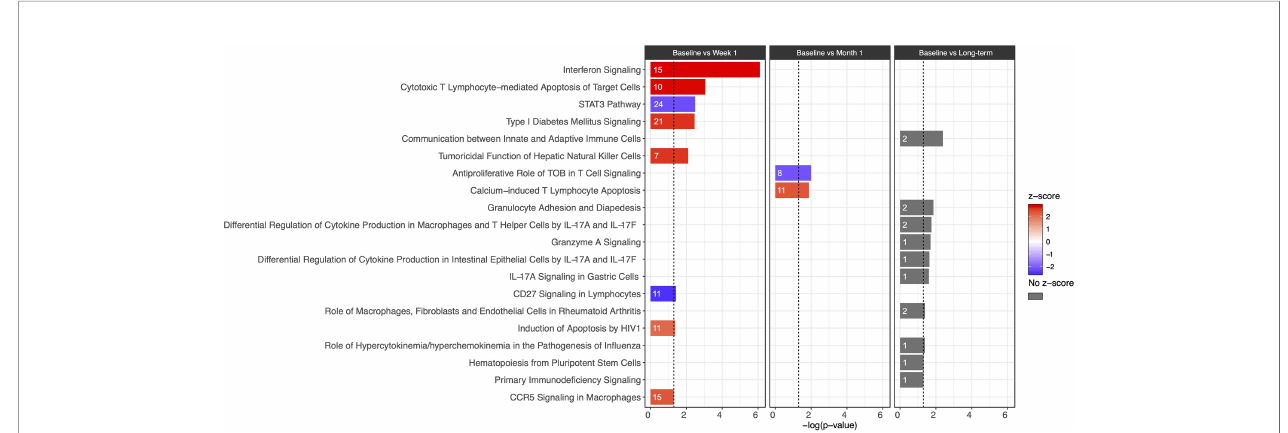
FIGURE 2 | Bar plot of IPA canonicalpathway analysis results comparingbaseline andweek1 ( fi rst column), baseline and month 1 (second column),and baselineand long-term(third column) for immunologicpathways. The signi fi canceof an enrichedpathway isrepresented bythe length of each bar,where length corresponds to the -log (p-value).The number ofgenes enrichingfor a pathway isindicated in the bar.The vertical dotted black line corresponds to a p-value of0.05. Positive IPA Z-scores are indicatedin red,and negative Z-scores are indicated inblue. Gray coloringisused for pathwaysinwhich direction ofchange cannot becon fi dently